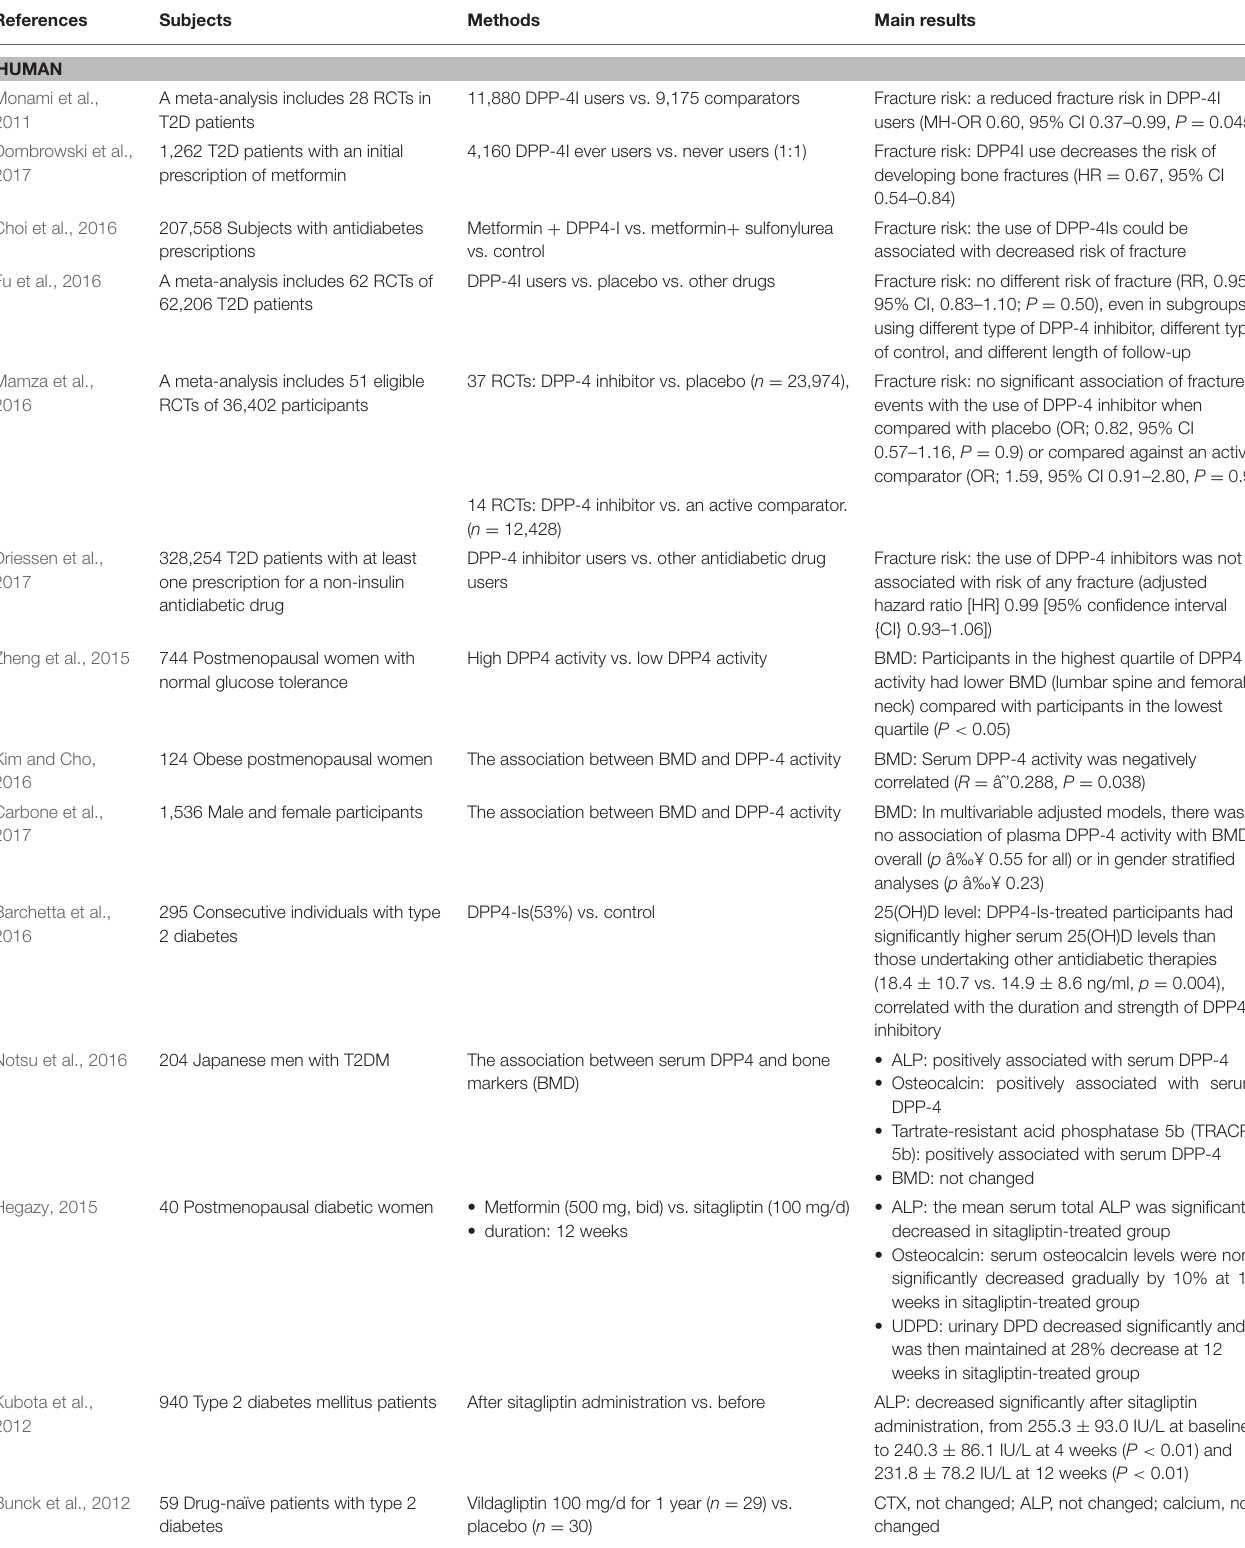
TABLE 1 | Published human and animal researches on the impact of DPP-4Is on bone